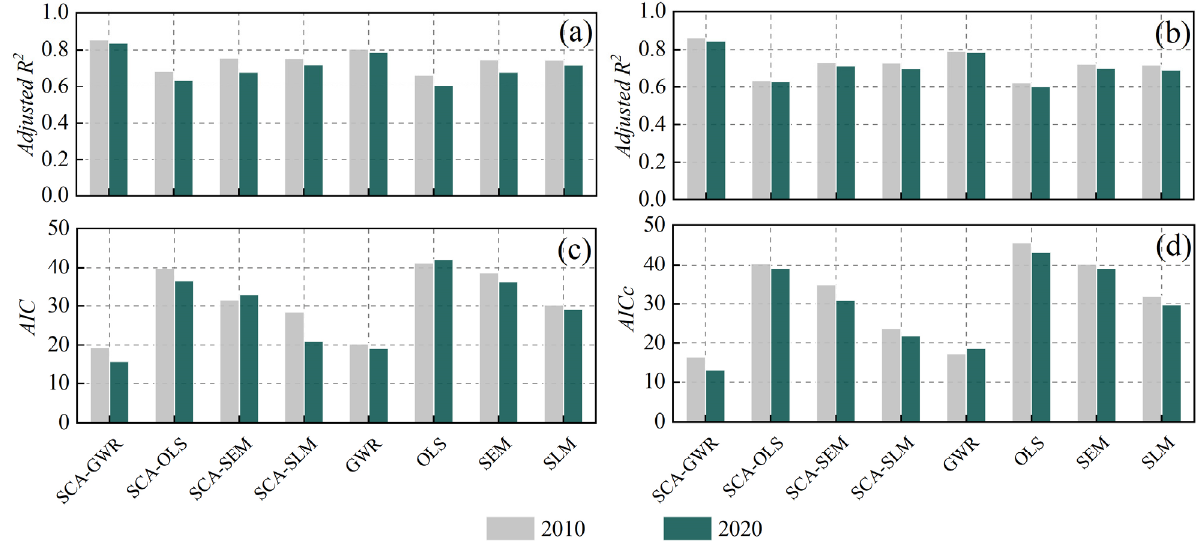
Figure 9. Model performance comparison. ( a ) R 2 ; ( b ) adjusted R 2 ; ( c ) AICc ; ( d ) AIC .